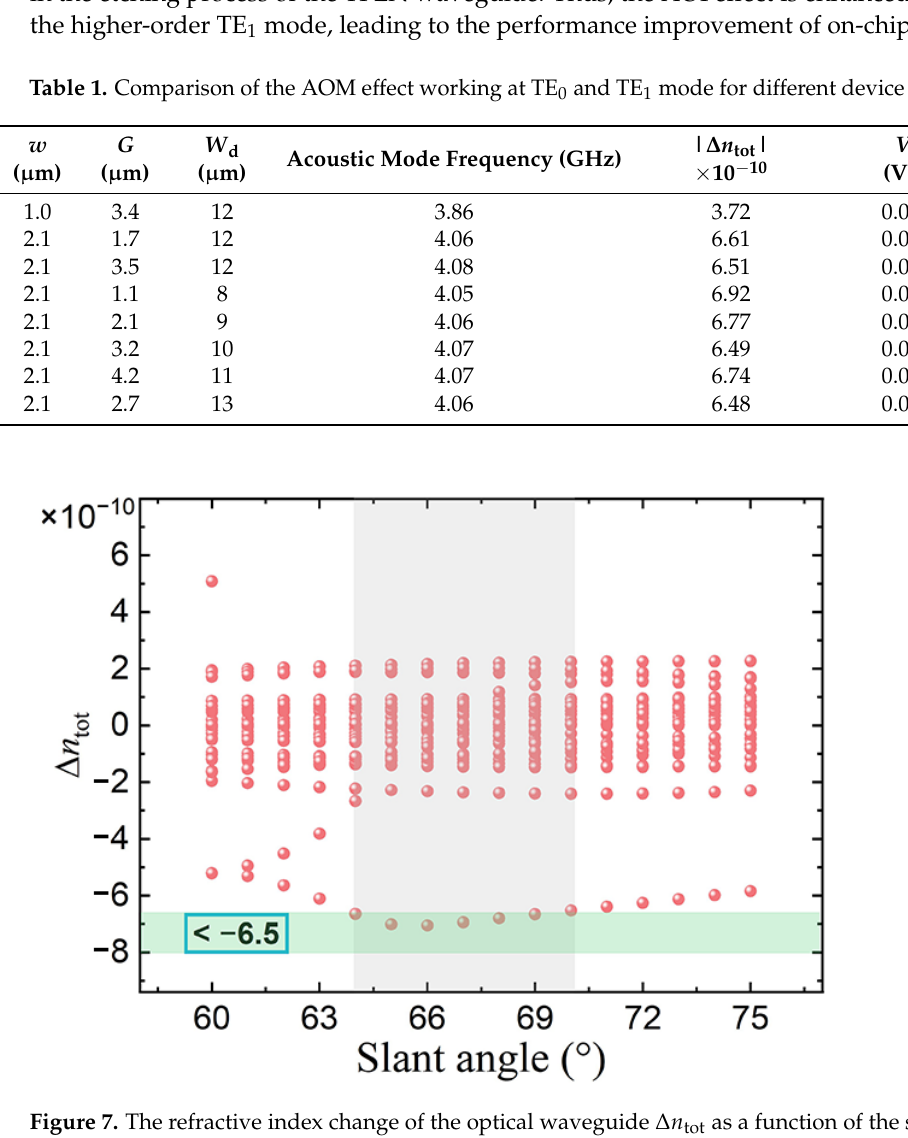
Figure 7. The refractive index change of the optical waveguide ∆ n tot as a function of the slant angle of the TFLN waveguide sidewall. Other structural parameters are the same as that in Figure 3b and G = 3.5 μ m